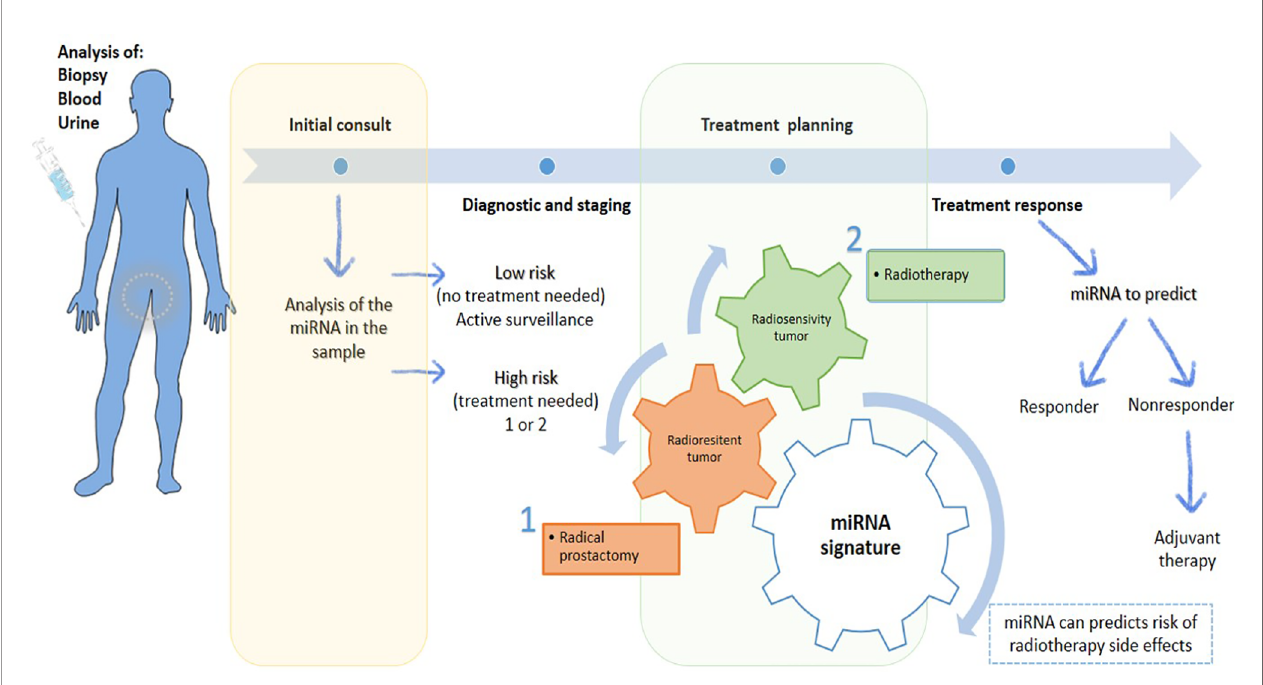
FIGURE 3 | Scheme of the potential of miRNAs in personalized prostate cancer. MiRNAs are present in biological samples, which could be a useful tool for diagnosis and staging in the fi rst consult, allowing an accurate risk strati fi cation. Based on information collected, the treatment can be planned. Treatments can be personalized according to radioresistance or radiosensitive of cancer. If cancer is radioresistance, radical prostatectomy is the therapeutic approach more indicated. Otherwise, RT is ideal treatment to apply to radiosensitive tumors. Also, miRNA signature can give information about the risk of develop side effects or if the patient is responding or not to treatment, leading to a better tumor control with reduced side effects, which contribute to a better patient quality